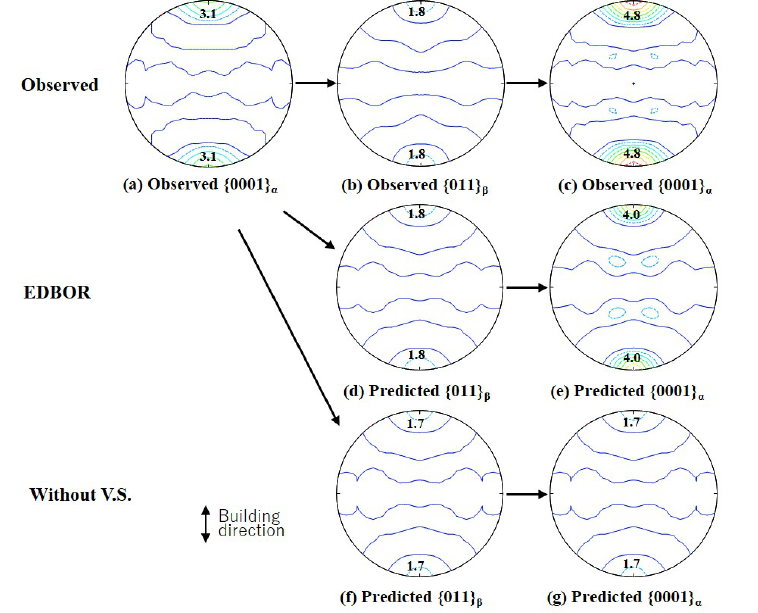
Figure 15. ( a – c ) Observed pole figures at ( a ) 900 ◦ C before transformation, ( b ) 1050 ◦ C and ( c ) 900 ◦ C after transformation, ( d – g ) predicted pole figures based on ( d , e ) DBOR mechanisms and ( f , g ) without variant selection. Levels are 1.0, 1.5, 2.0, 2.5...